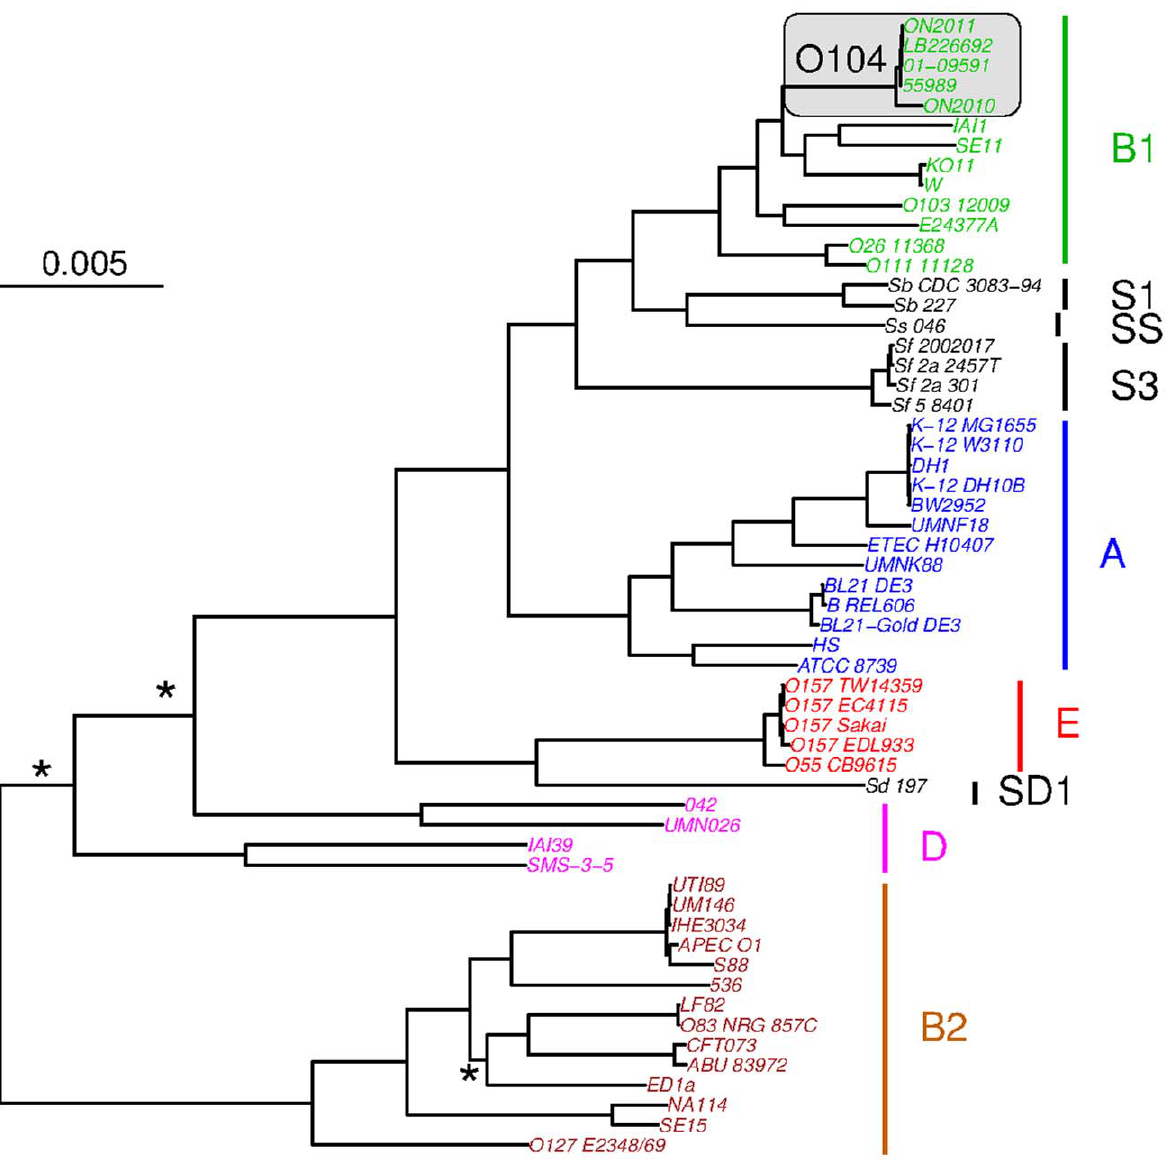
Figure 1. Maximum likelihood phylogenetic tree of the 58 Escherichia and Shigella strains (57 E.coli/Shigella + E.fergusonii ) as reconstructed from the sequences of 2085 universally present single-copy genes (1962650 characters in total). E. fergusonii was chosen to root the tree. Three internal branches that are not well supported (with a bootstrap value , 90) are labeled as asterisks. Phylogenetic group membership of the strains is indicated with bars at the right of the figure. The E. coli O104 strains are